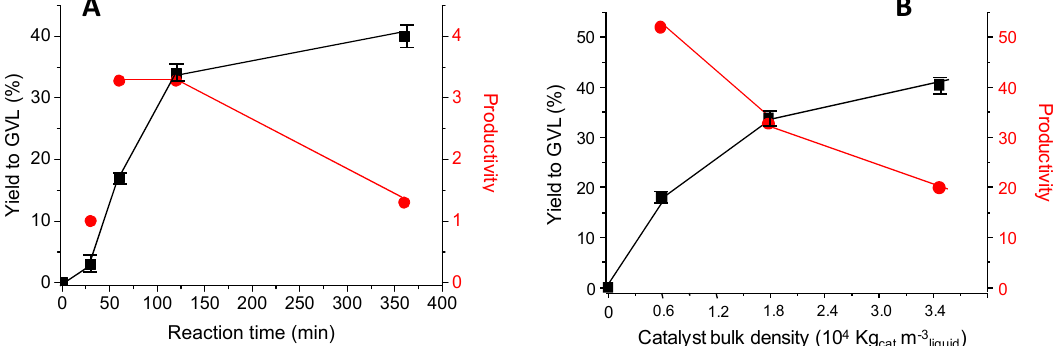
Figure 8. Influence of the reaction time ( A ) and the catalyst bulk density ( B ) on the yield to γ -valerolactone ( ■ ) and on the productivity to γ -valerolactone per mass of catalyst ( ● ) using NiNC catalyst. Notes: Reaction temperature = 180 °C. ( A ) Catalyst weight = 62.5 mg and different reaction times. ( B ) Reaction time = 2 h and different catalyst bulk densities. Productivity per mass of catalyst expressed as mol GVL Kg cat − 1 h − 1 .